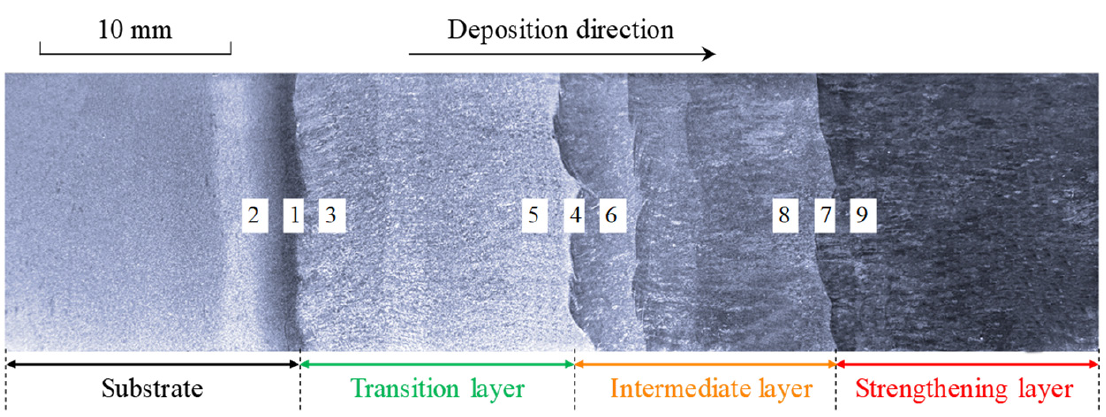
Figure 6. The macroscopic view of the GAL. Numbers 1–9 indicated the observation positions of microstructure in Figures 7–9.